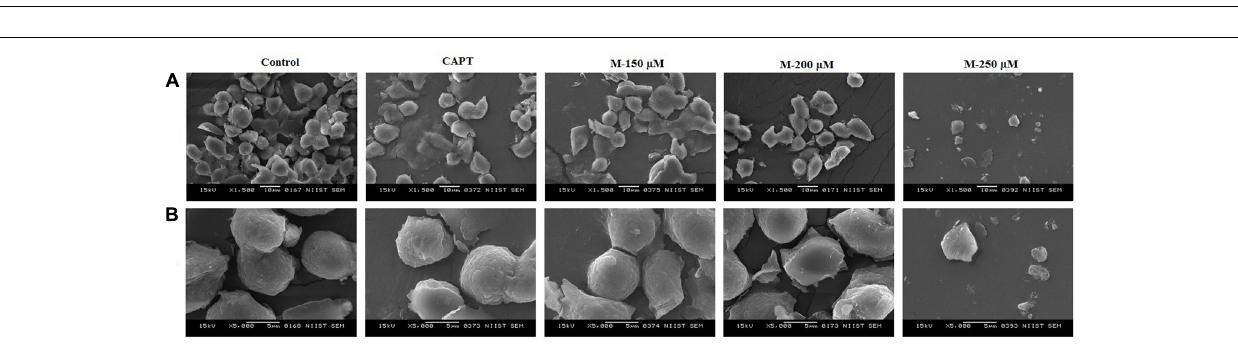
FIGURE 2 | Scanning electron microscopic images of SW480 cells at 48 h after morin treatment. SW480 cells were treated with various concentrations of morin (150, 200, and 250 µ M) and camptothecin (50 µ M) for 48 h. After incubation, morphological changes were observed under SEM at magnification of 1500 × (A) and 5000 × (B)